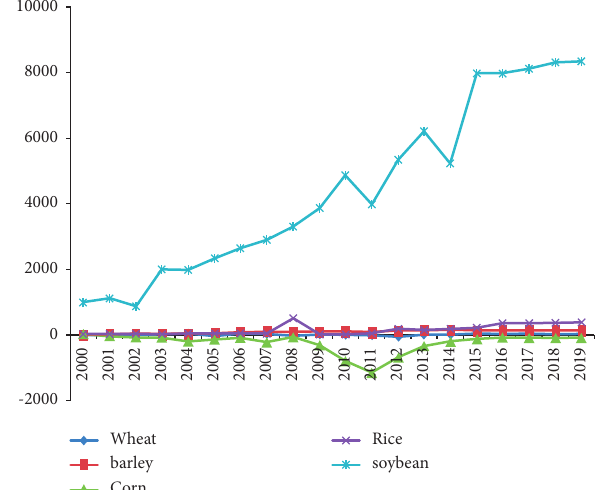
Figure 4: Net imports of major grains in China (unit: 10,000